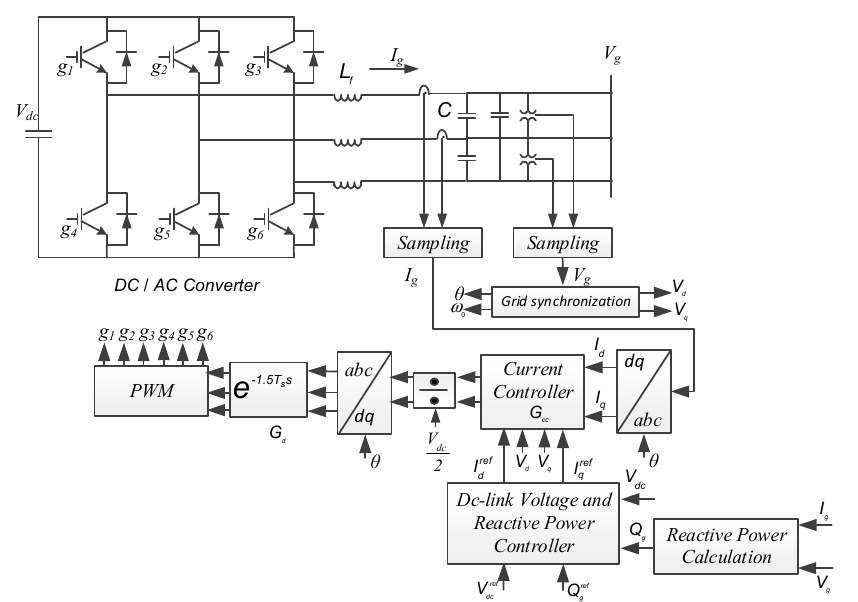
Figure 2. Grid side converter and its control, as typically used in wind turbines.